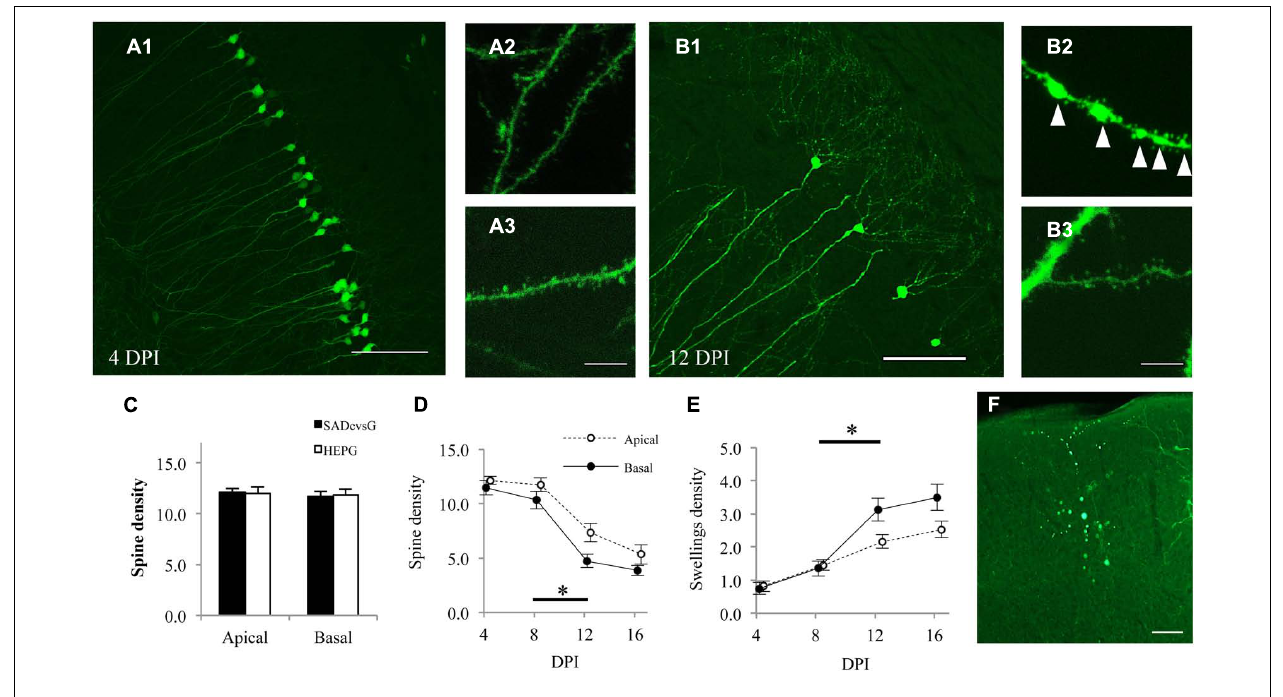
FIGURE 8 | HEP- Δ G-GFP itself, but not RVG variants, causes neuronal degeneration. Morphology of CA1 pyramidal neurons on (A) 4 DPI and (B) 12 DPI. Spines on basal (A2 , B2) and apical (A3,B3) dendrites were analyzed. Fewer spines and more dendritic swellings (arrowheads in B2 ) were observed on both apical and basal dendrites on 12 DPI. (C) Dendritic spine density following infection with SADcvsG- or HEPG-coated HEP- Δ G-GFP. Spine density was calculated as the number of spines per 10 μ m of apical or basal